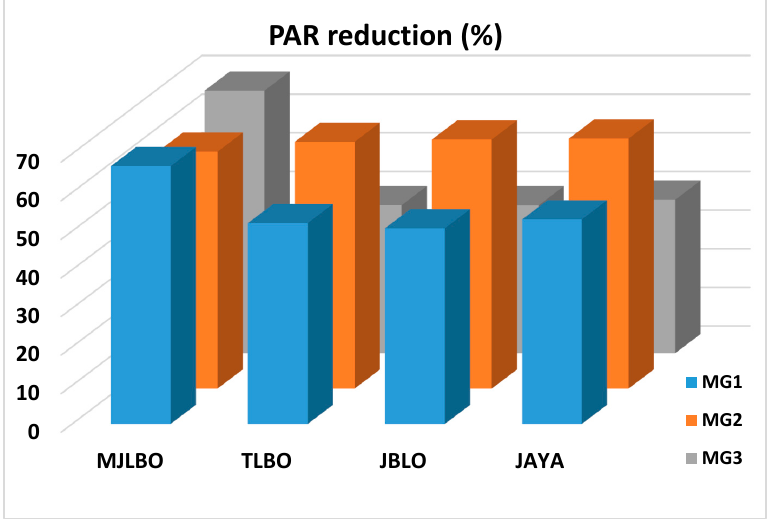
Figure 30. Percent PAR reduction of each MG for MJLBO, TLBO, JLBO, and JAYA.